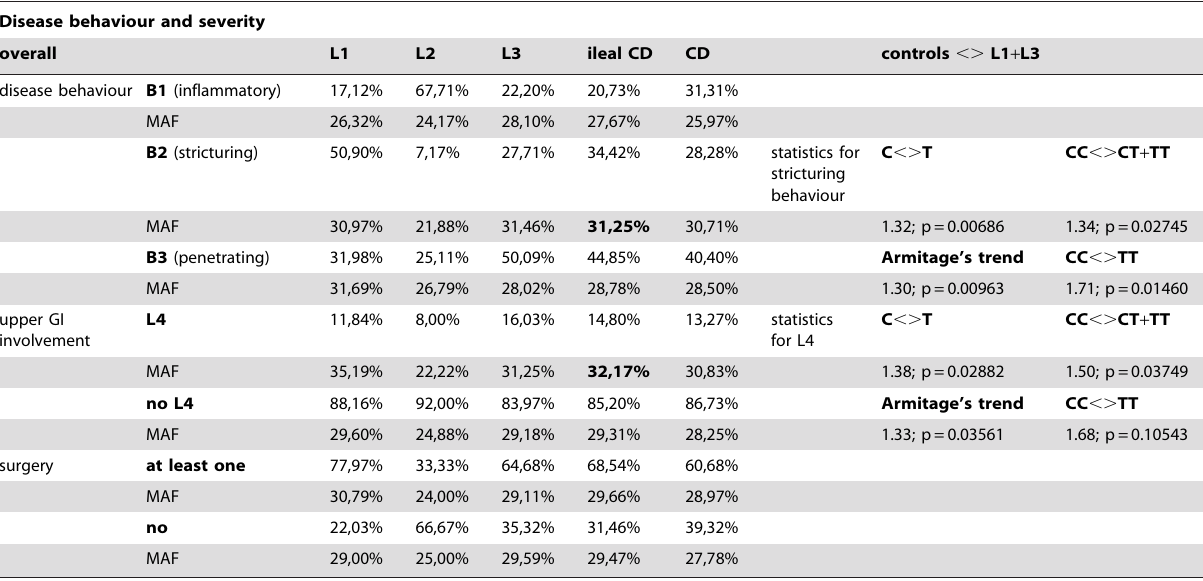
Disease behaviour and